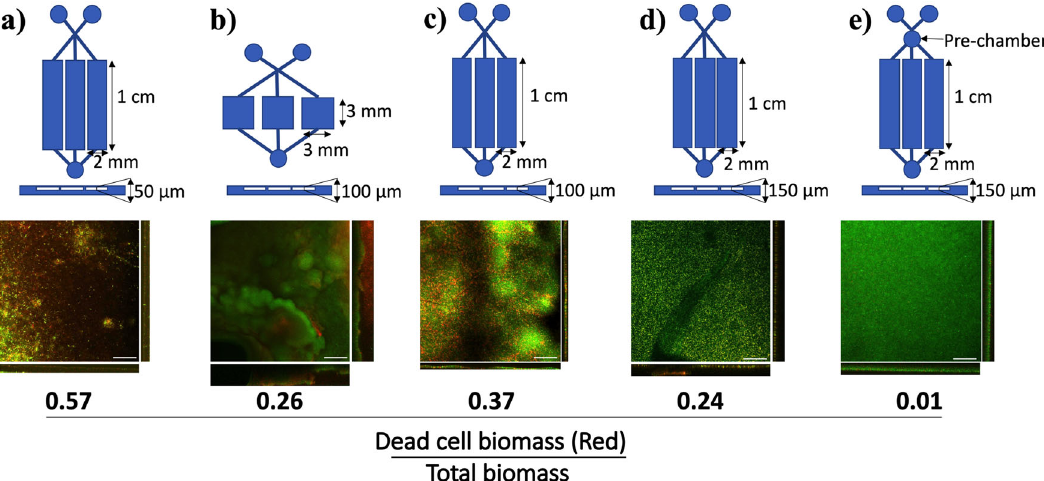
Fig. 2 Bio fi lmChip dimensions, geometry and functional characterization. schematic representations of the different manufactured chip geometries. The P. aeruginosa PAO1 bio fi lm structure formed in each chip is shown in the confocal microscopy images (sum and orthogonal views). In all cases, the bio fi lm was grown for 72 h and stained with the LIVE/DEAD BacLight Bacterial Viability Kit. At the bottom of the images, average proportion of dead cells (stained in red) in the total bio fi lm biomass from three different experiments is shown. Scale bar represents 50 μ